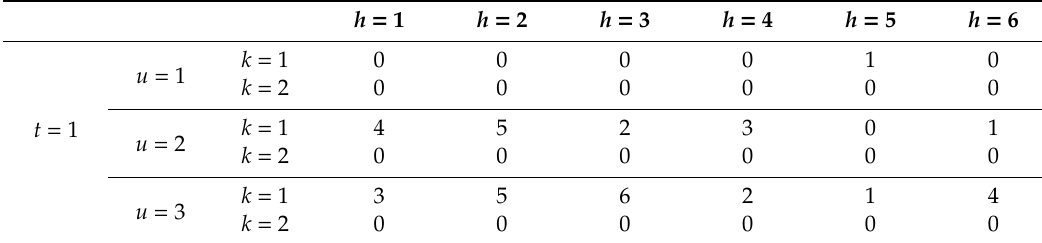
Table 26. Sequence of supplying instruments to hospitals with selected vehicles in period t =